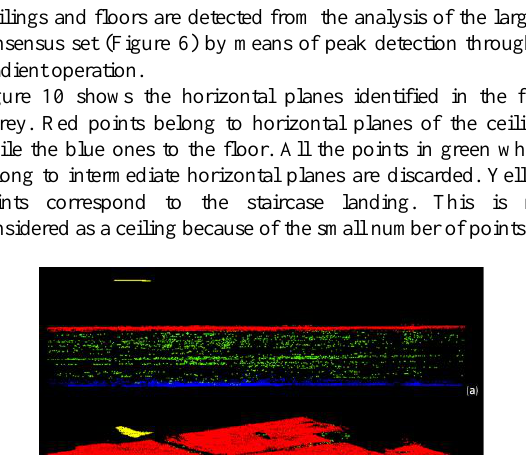
Figure 13. Floor of second